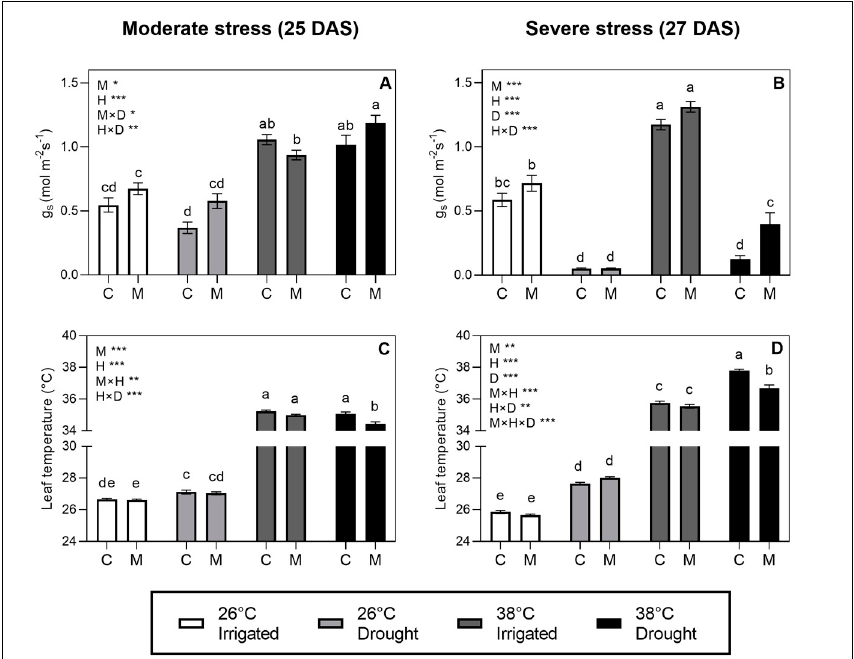
Figure 1. Stomatal conductance (g s ) ( A , B ) and leaf temperature ( C , D ) measured in situ on plants during moderate stress (drought-stressed at SRWC ~50% and heat stress for 1 day) and severe stress (drought-stressed at SRWC ~20% and heat stress for 3 days). Values are mean ± SE. The effects of the three factors studied - heat stress (H), drought stress (D), melatonin treatment (M)-and their interaction are indicated in the left, upper corners of graphs. Significance levels are indicated by ***, p < 0.001; **, p < 0.01; *, p < 0.05, whereas factors with no significant effect ( p > 0.05) are not listed. Lower-case letters on bars indicate differences between groups within each stress level significant at p < 0.05 in the post hoc multiple comparisons.